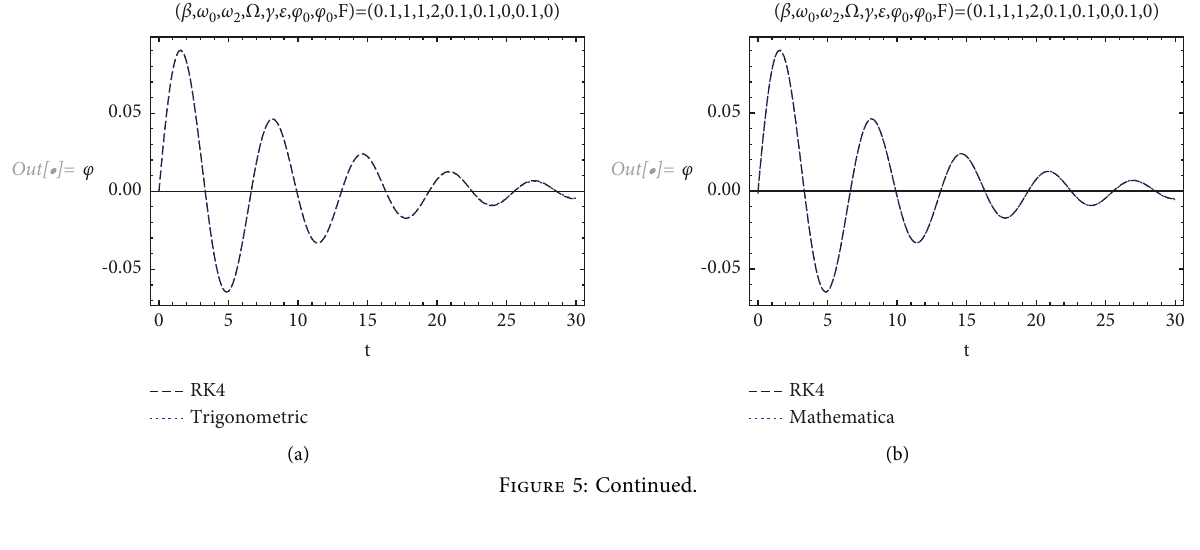
β , ω 2 , F 0 , 1 , 0 . 1 ( ) (cid:28) ( )